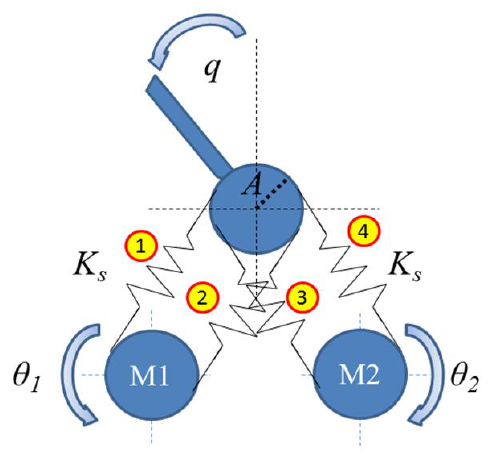
Figure 4. Bidirectional class of stiffness adjustment